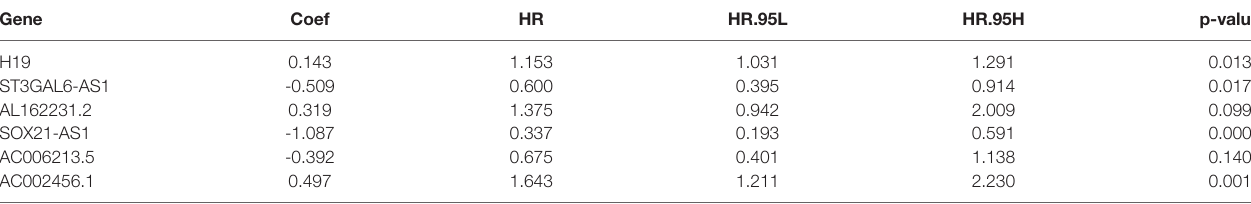
TABLE 1 | Coef fi cients based on a multivariate Cox regression analysis of the selected lncRNAs. Gene Coef